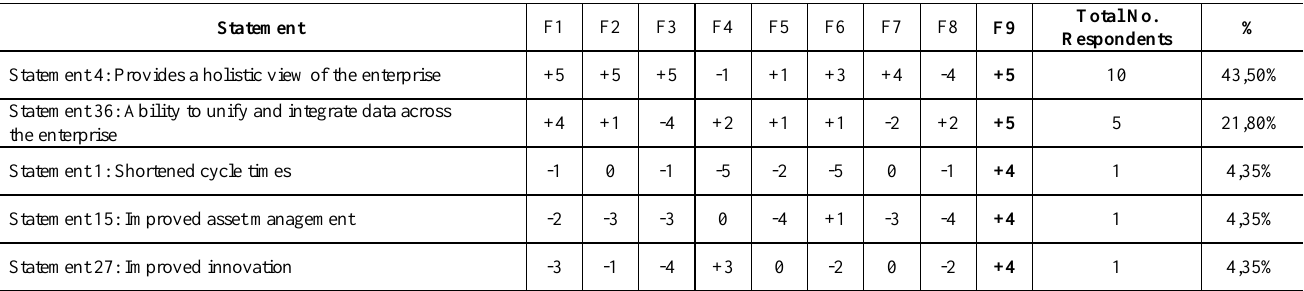
Table 13: Factor 9. Siloed product manager, key